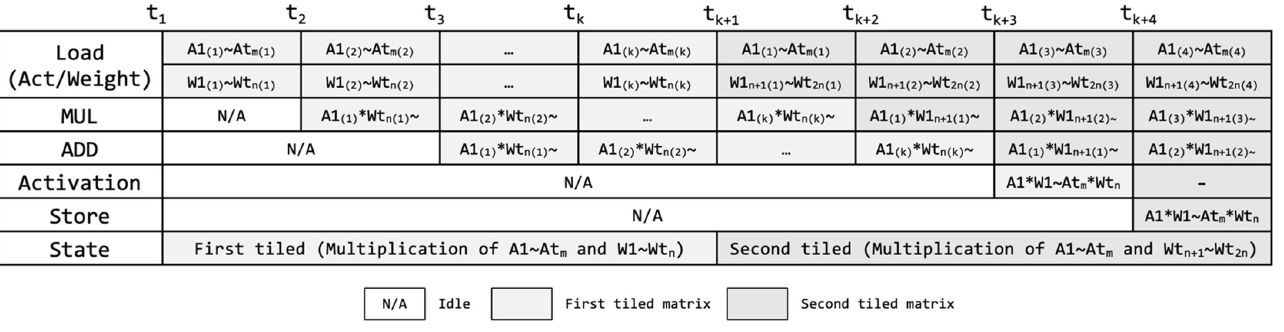
Figure 11. Illustration of the five-stage pipelined execution in CONNA: Load, two stages for computation, activation, and store.